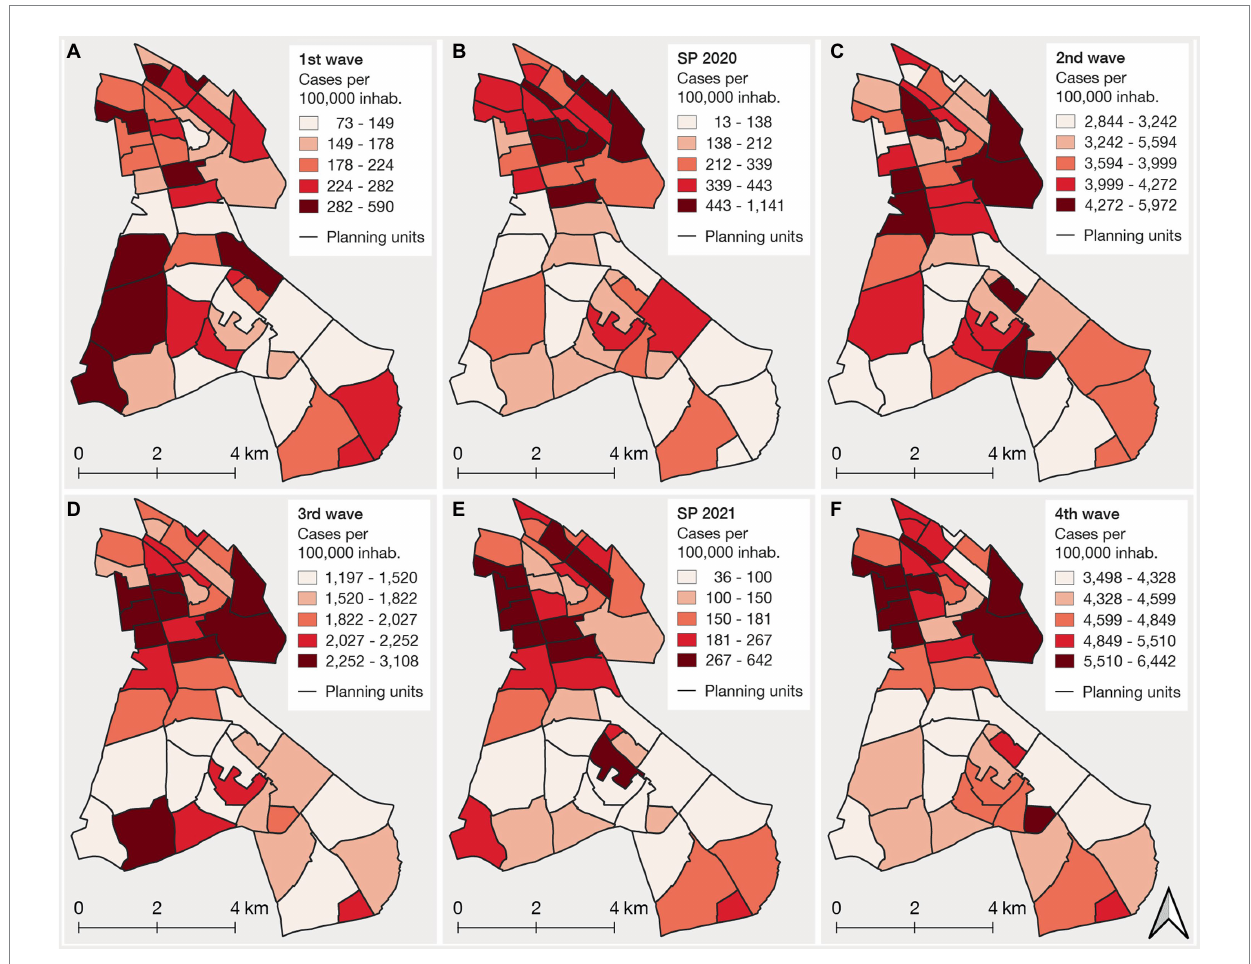
FIGURE 3 Cumulative incidence rate maps across the six pandemic phases, including the four waves (A,C,D,F) and two summer plateaus (SP) (B,E) during the study